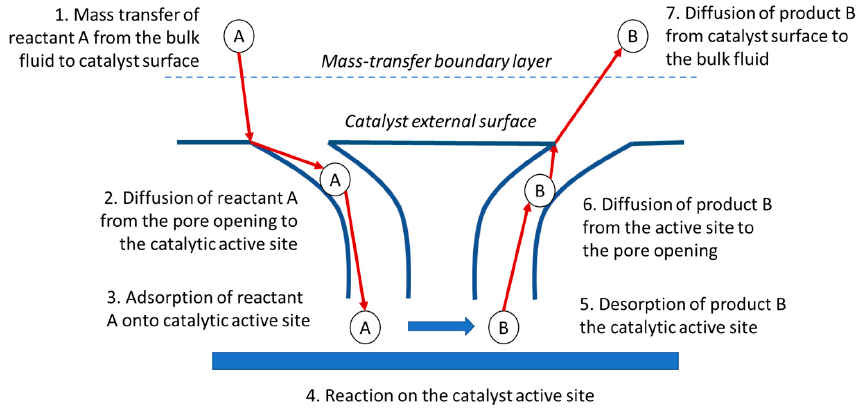
Figure 5. Steps in a Heterogeneous Catalytic Reaction [21].